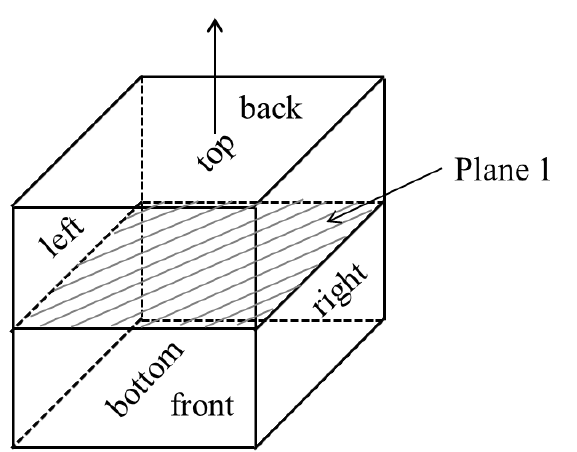
Figure 7. Simulation domain for cases at zero gravity.